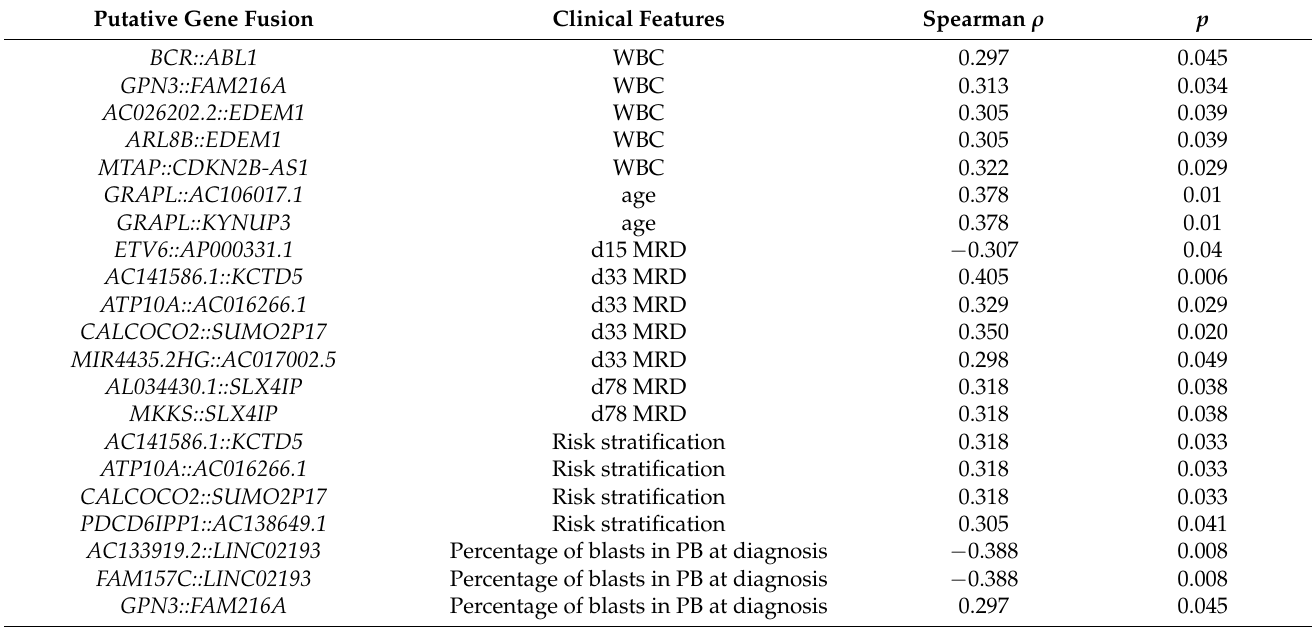
Table 6. Correlations of recurrent putative fusion genes with clinical features of B-ALL in children. Putative Gene Fusion Clinical Features